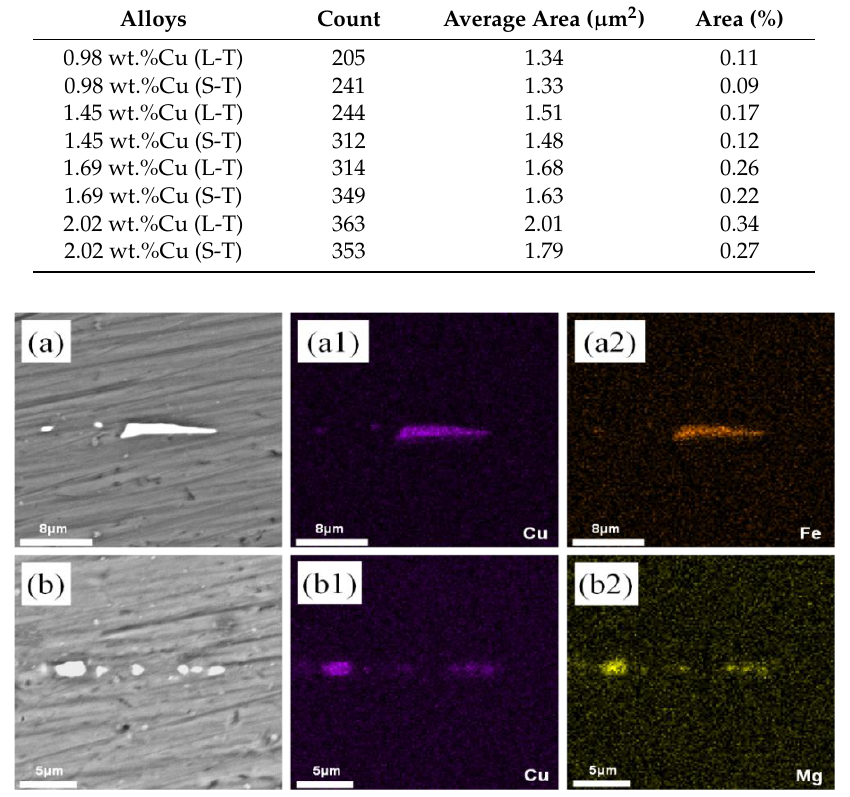
Figure 3. SEM images of the alloys with different Cu contents: ( a , e ) 0.98 wt.%Cu; ( b , f ) 1.45 wt.%Cu; ( c , g ) 1.69 wt.%Cu; ( d , h ) 2.02 wt.%Cu; L-T: ( a – d ); S-T: ( e – h ). Table 2. Analysis of the count, average area and area fraction of second phase in the alloy.